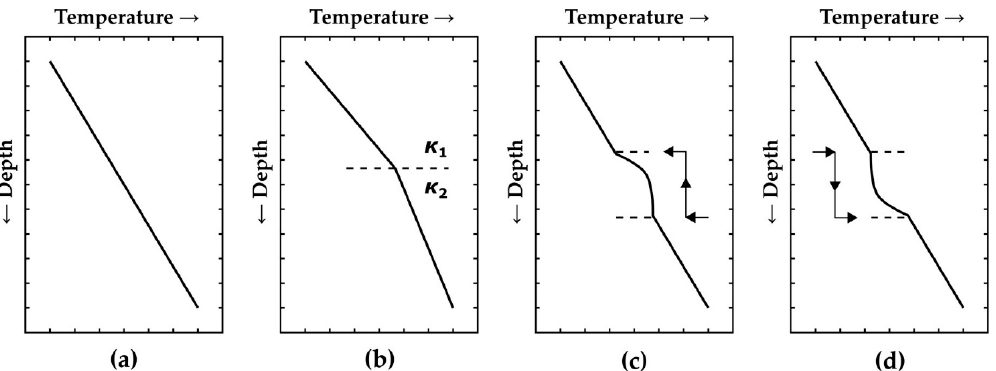
Figure 3. Schematic temperature–depth profiles with various underground conditions (adapted from Kim and Song [2] and Beck and Balling [35]): ( a ) temperature profile with underground equilibrium; ( b ) temperature profile with different thermal conductivities ( κ 1 and κ 2 ), wherein the borehole consists of different thermal conductivities; and ( c , d ) temperature profile with a nonlinear thermal gradient, which is affected by the groundwater flow from both warm and cool origins.